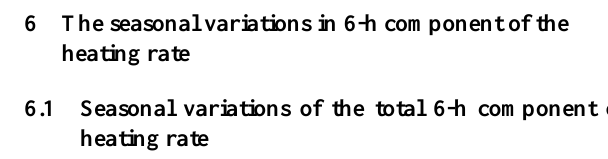
Figure 14 The multi-year averaged vertical profiles of the symmetrical (a) and asymmetrical (b) terdiurnal Hough functions for equinox/Mar (solid line) and solstice/Jun (dashed line).